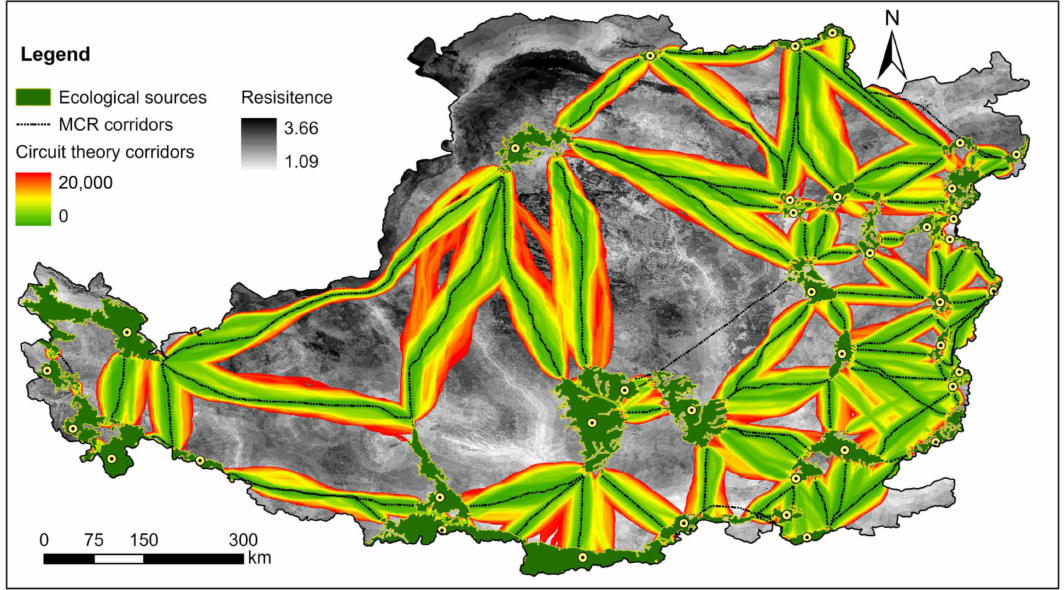
Figure 9. Comparison of ecological corridors constructed by the MCR model and circuit